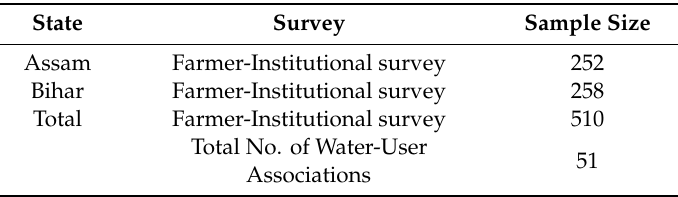
Table 3. Survey sample coverage.